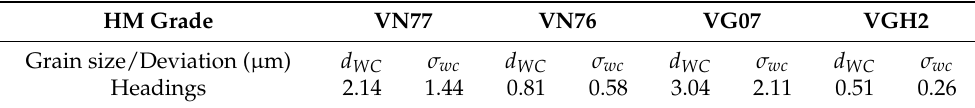
Table 3. Grain size in µ m measured by EBSD with standard